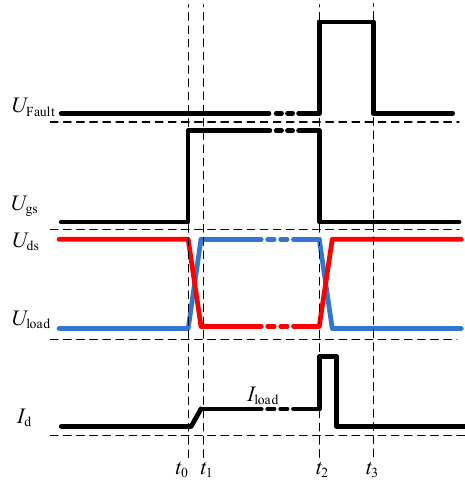
Figure 2. Operating principles of SSCB.